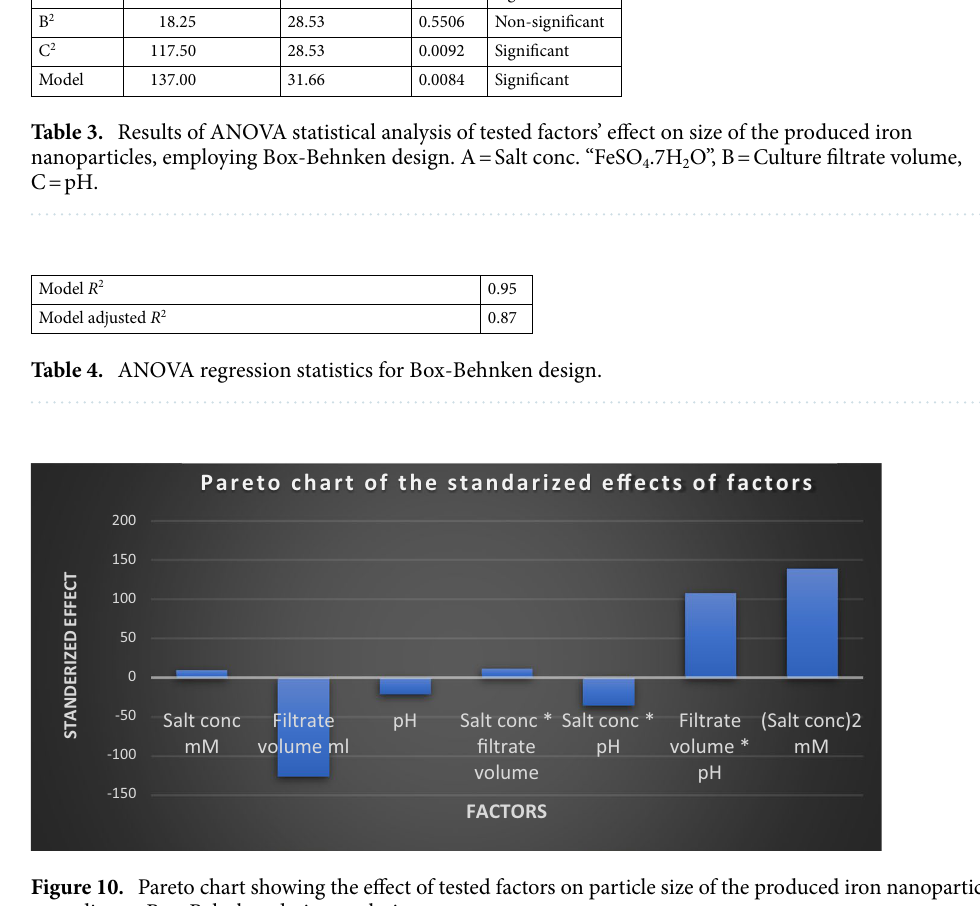
Figure 10. Pareto chart showing the effect of tested factors on particle size of the produced iron nanoparticles according to Box-Behnken design